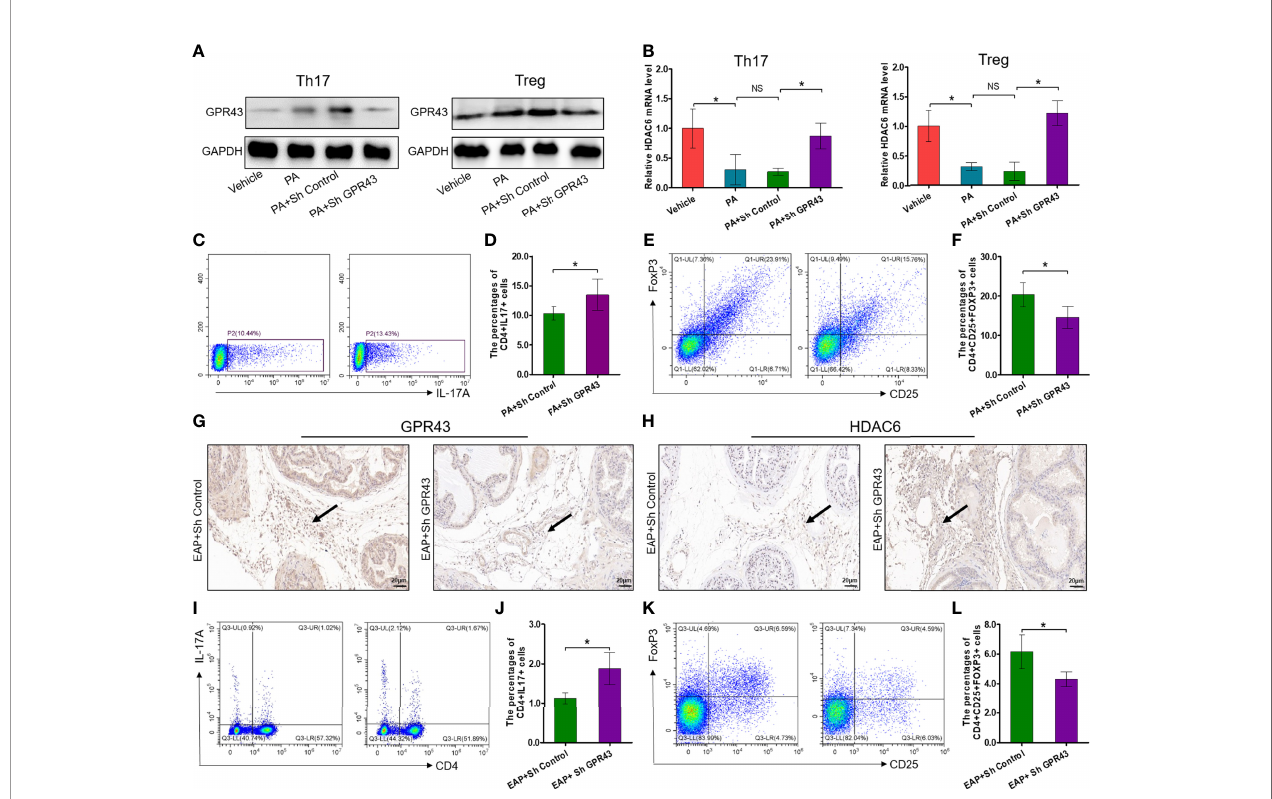
FIGURE 7 | Propionic acid regulates Th17/Treg cell differentiation by modulation of the GPR43 – HDAC6 axis. (A) Immunoblot analysis of GPR43 expression levels in CD4 + T cell under Th17/Treg differentiation conditions that were assigned to four groups: vehicle group (without treatment), PA group (incubated with propionic acid), PA+sh Control group (incubated with propionic acid and LV-sh Control), and PA+sh GPR43 group (incubated with propionic acid and LV-sh GPR43). (B) The relative mRNA expressions of HDAC6 in the four groups as detected by RT-qPCR assay. (C) Representative pictures of fl ow cytometric staining for CD4 + IL-17 + cells in the PA+sh Control group and the PA+sh GPR43 group. (D) Flow cytometric analysis of the proportion of CD4 + IL-17 + cells in the PA+sh Control group and the PA +sh GPR43 group. (E) Representative pictures of fl ow cytometric staining for CD4 + CD25 + FoxP3 + cells in the PA+sh Control group and the PA+sh GPR43 group. (F) Flow cytometric analysis of the proportion of CD4 + CD25 + FoxP3 + cells in the PA+sh Control group and the PA+sh GPR43 group. (G) Immunohistochemical analysis of GPR43 expression in prostate of EAP mice treated with LV-sh Control or LV-sh GPR43. Results indicate a decrease in GPR43 expression in prostatitic in fl ammatory cells of EAP mice treated with LV-sh GPR43. The black arrows indicate the GPR43-positive in fl ammatory cells in the two groups. (H) Immunohistochemical analysis of HDAC6 expression in prostate of EAP mice treated with LV-sh Control or LV-sh GPR43. Results indicate an increase in HDAC6 expression in prostatitic in fl ammatory cells of EAP mice treated with LV-sh GPR43. The black arrows indicate the HDAC6-positive in fl ammatory cells in the two groups. (I) Representative pictures of fl ow cytometric staining for CD4 + IL-17 + cells in EAP mice treated with LV-sh Control or LV-sh GPR43. (J) Flow cytometric analysis of the proportion of CD4 + IL-17 + cells in in EAP mice treated with LV-sh Control or LV-sh GPR43. (K) Representative pictures of fl ow cytometric staining for CD4 + CD25 + FoxP3 + cells in the splenic lymphocytes from EAP mice treated with LV-sh Control or LV-sh GPR43. (L) Flow cytometric analysis of the proportion of CD4 + CD25 + FoxP3 + cells in EAP mice treated with LV-sh Control or LV-sh GPR43. Data are representative of three independent experiments. n = 3 – 5/group; * p < 0.05; ** p < 0.01; EAP, experimental autoimmune prostatitis; SCFA, short-chain fatty acid; NS, not signi fi cant; PA, propionic acid; GPR43, G-protein-coupled receptor 43; HDAC6, histone deacetylase 6; LV, lentivirus; IL-17, interleukin-17; FoxP3, forkhead box P3; Treg, regulatory T